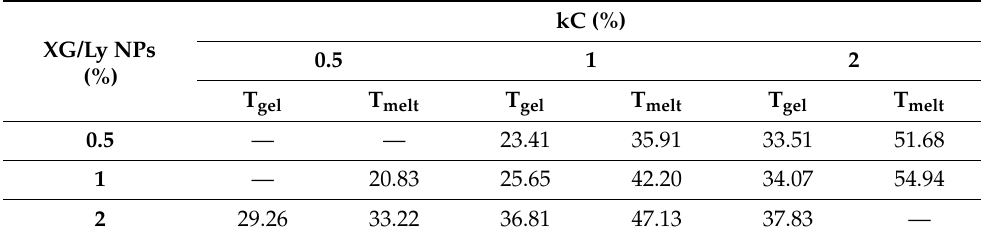
Table 1. Gelation (T gel ) and gel-melting (T melt ) temperature (°C) of Pickering emulsion gels in different XG/Ly NPs concentrations coupled with different concentrations of kC.